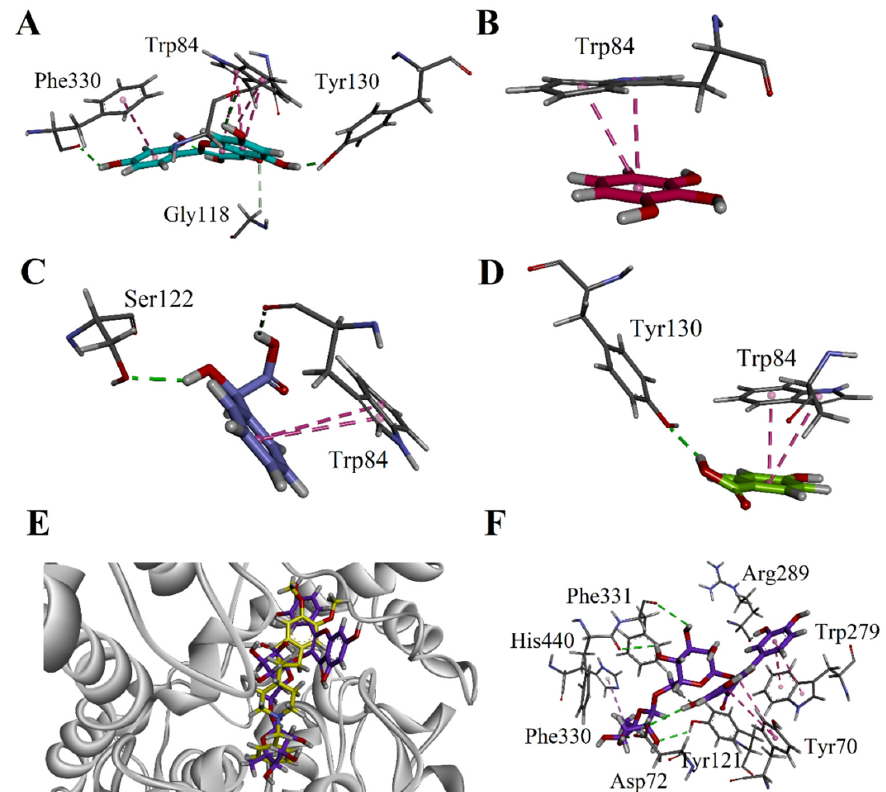
Figure 6. Close-up view interaction plots of the docked-pose showing important residues, morin ( A ), pyrogallol ( B ), mandelic acid ( C ), and hydroxybenzoic acid ( D ). The overlaid ribbon diagram of rutin and native ligand donepezil (yellow) into the binding site of TcAChE (1EVE) ( E ) and close-up depiction of the lowest-energy three-dimensional (3-D) docking poses of rutin ( F ). Rutin is quercetin-3- O -rutinoside, the ribbon model of rutin superposed on native donepezil,